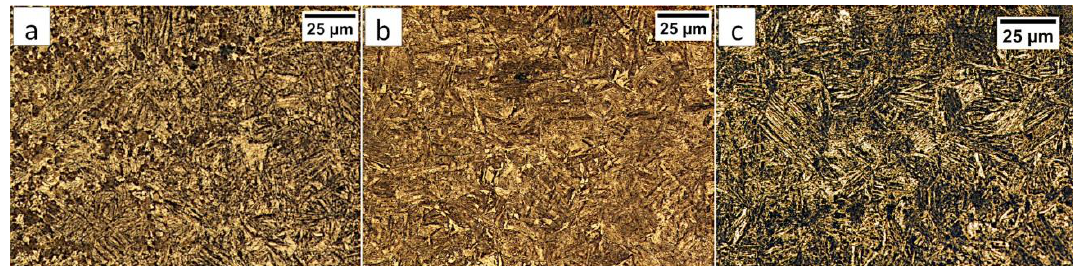
Figure 12. ( a ) The structure of the boundary between HTHAZ and LTHAZ in the area “C/D” (marked in Figure 4). Bainite with cementite precipitations and pearlite. ( b ) The structure of the LTHAZ in the area “D” (marked in Figure 4). Degraded bainite. ( c ) The structure of the base material in the area “E” (marked in Figure 4). Degenerated upper bainite. Etched by nital, LM.